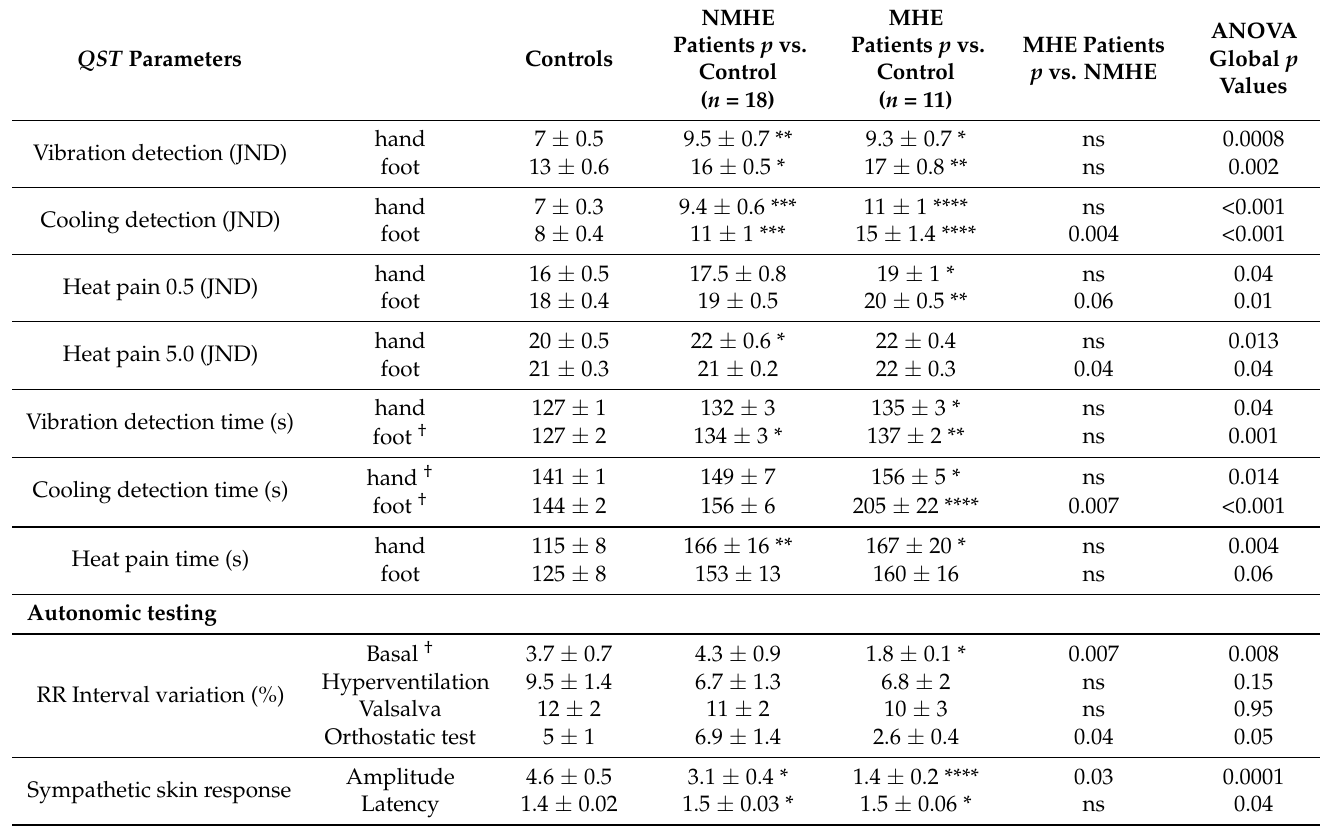
Table 4. Comparison of QST parameters and autonomic testing in patients with normal sural nerve amplitude. QST Parameters Controls